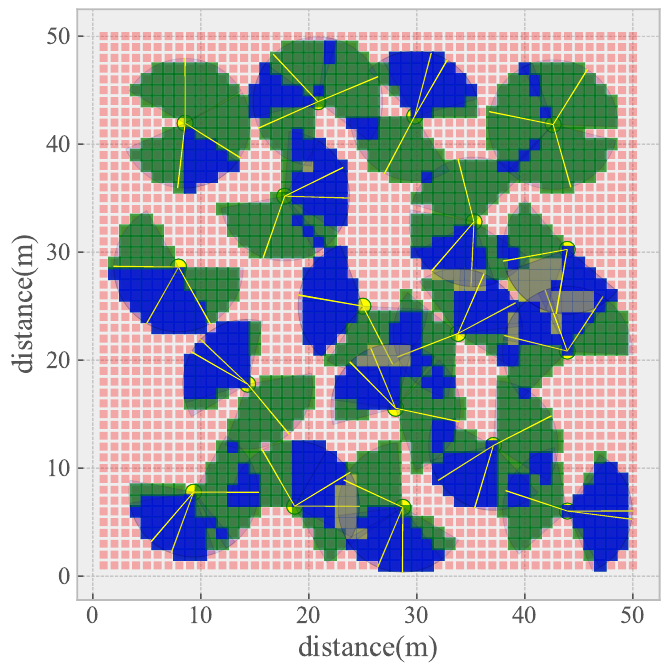
Figure 9. Initial coverage of a real DSN deployment